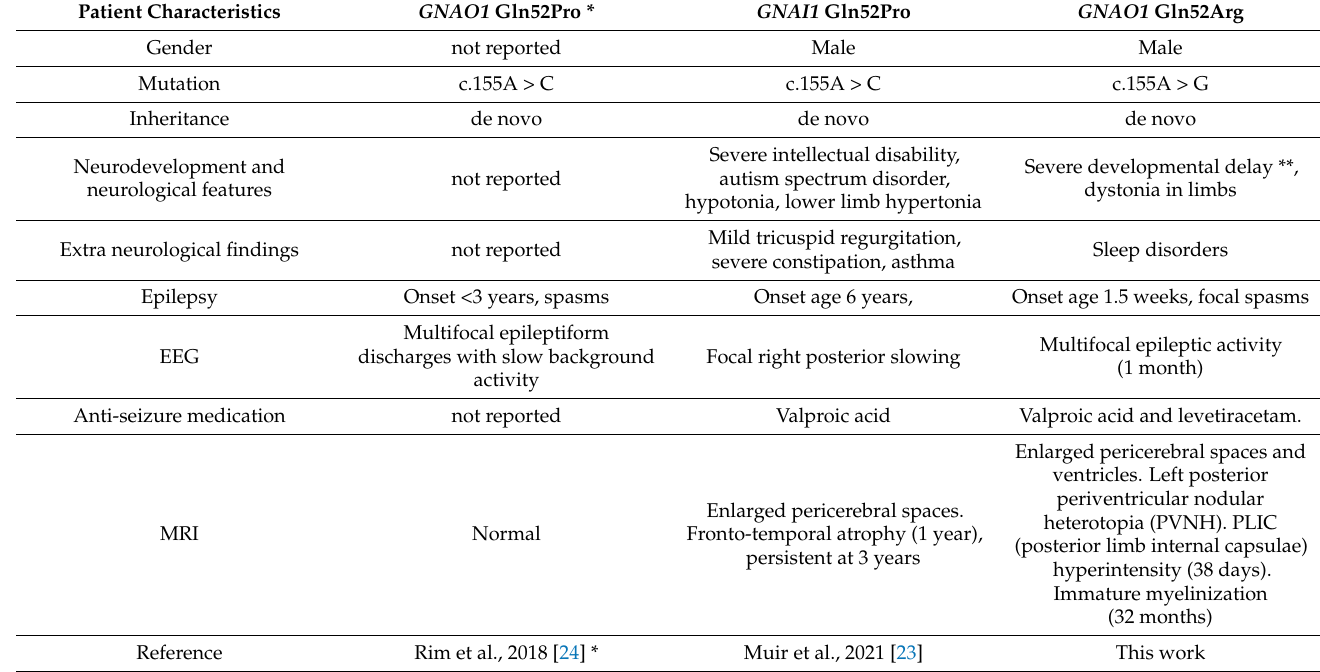
Table 1. Description of patients with GNAO1 and GNAI1 Gln52